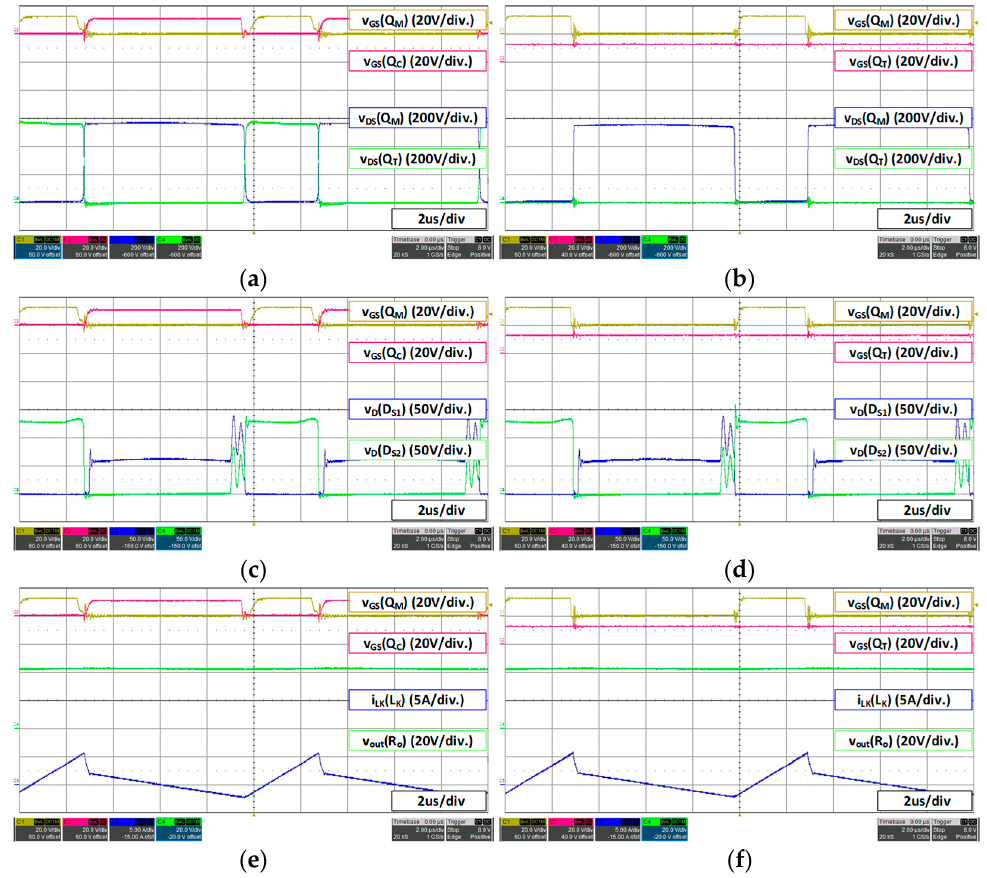
Figure 13. 36 V battery (42 V 4.5 A) load waveform: ( a ) conventional converter MOSFET voltage stress; ( b ) proposed converter MOSFET voltage stress; ( c ) conventional converter secondary rectifier voltage stress; ( d ) proposed converter secondary rectifier voltage stress; ( e ) conventional converter V out ; ( f ) proposed converter V out .